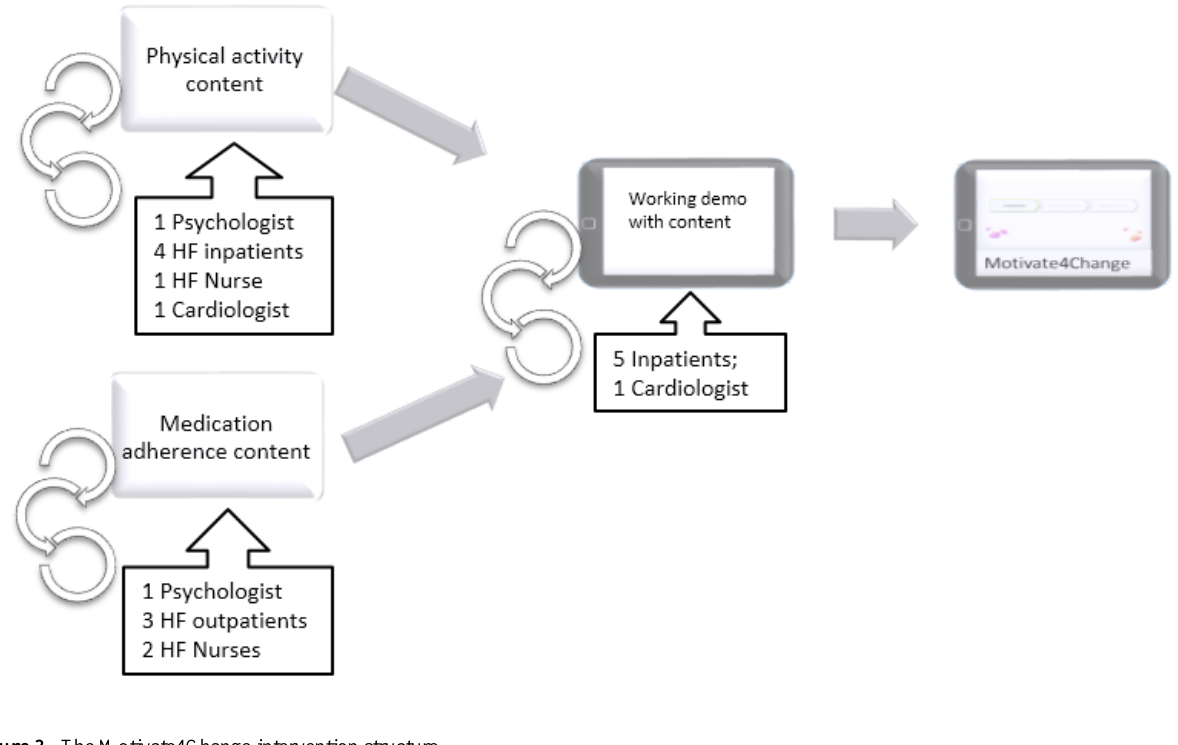
Figure 3. The Motivate4Change intervention